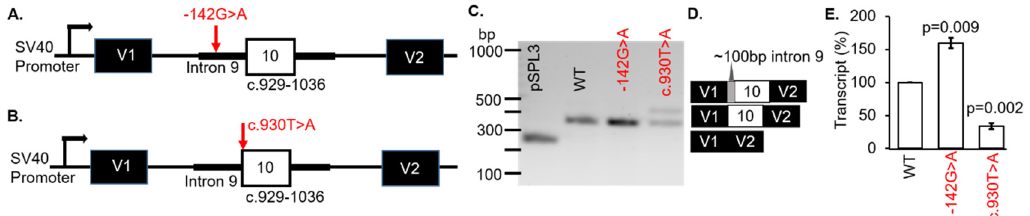
Figure 4. CLUAP1 VUS disrupted splicing in a minigene splice assay. ( A , B ) Diagrams showing the genomic region and location of the variants cloned into the pSPL3 vector. ( C ) Representative RT-PCR analysis from COS-7 cells transi-ently transfected with the single constructs as indicated. ( D ) Sanger sequencing showed vector exons only for the empty vector (V1 + V2), correctly spliced transcripts containing exon 10, and abnormal transcripts that also included ~100 bp of additional sequences. ( E ) The percentage of wild-type (WT) transcript was significantly different for both VUS. V1 and V2, and vector exons 1 and 2, respectively. bp: base pair.